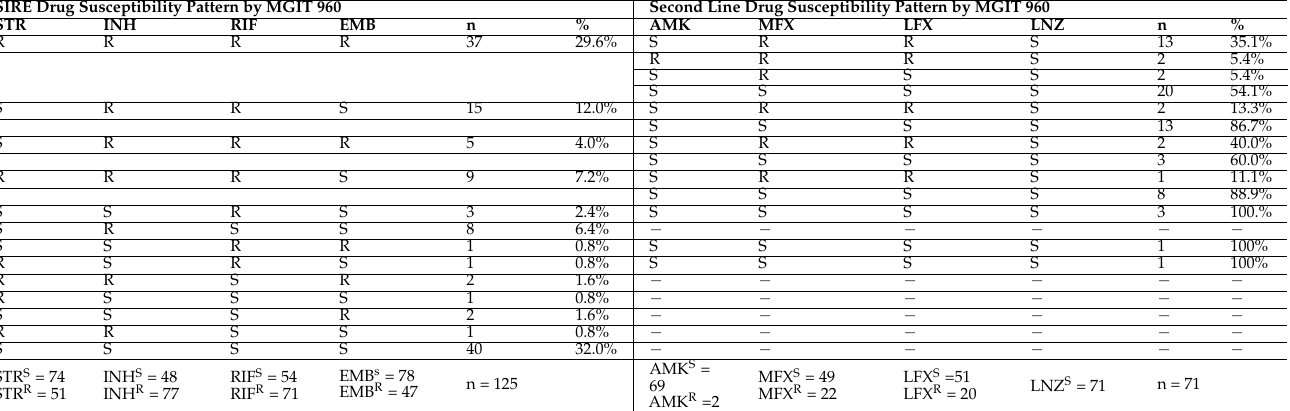
Table 1. Association of first-line drug-resistant patterns with second-line DST on Bactec MGIT-960. SIRE Drug Susceptibility Pattern by MGIT 960 Second Line Drug Susceptibility Pattern by MGIT 960